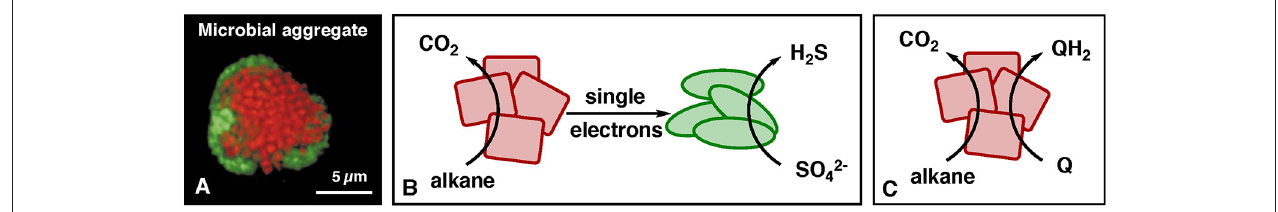
FIGURE 1 | Alkane oxidation by environmental microbes. (A) Microscopy picture of a microbial aggregate that performs methane oxidation coupled to sulfate reduction [from Reference (Boetius et al., 2000)]. Red microbes = methane-oxidizing archaea, green microbes = sulfate-reducing bacteria. (B) Process of alkane oxidation by environmental archaea (red) with electron transfer to sulfate-reducing partner bacteria (green). (C) Coupling of alkane oxidation with the reduction of synthetic electron carriers (Q), as demonstrated for the alkane methane (Scheller et al., 2016).